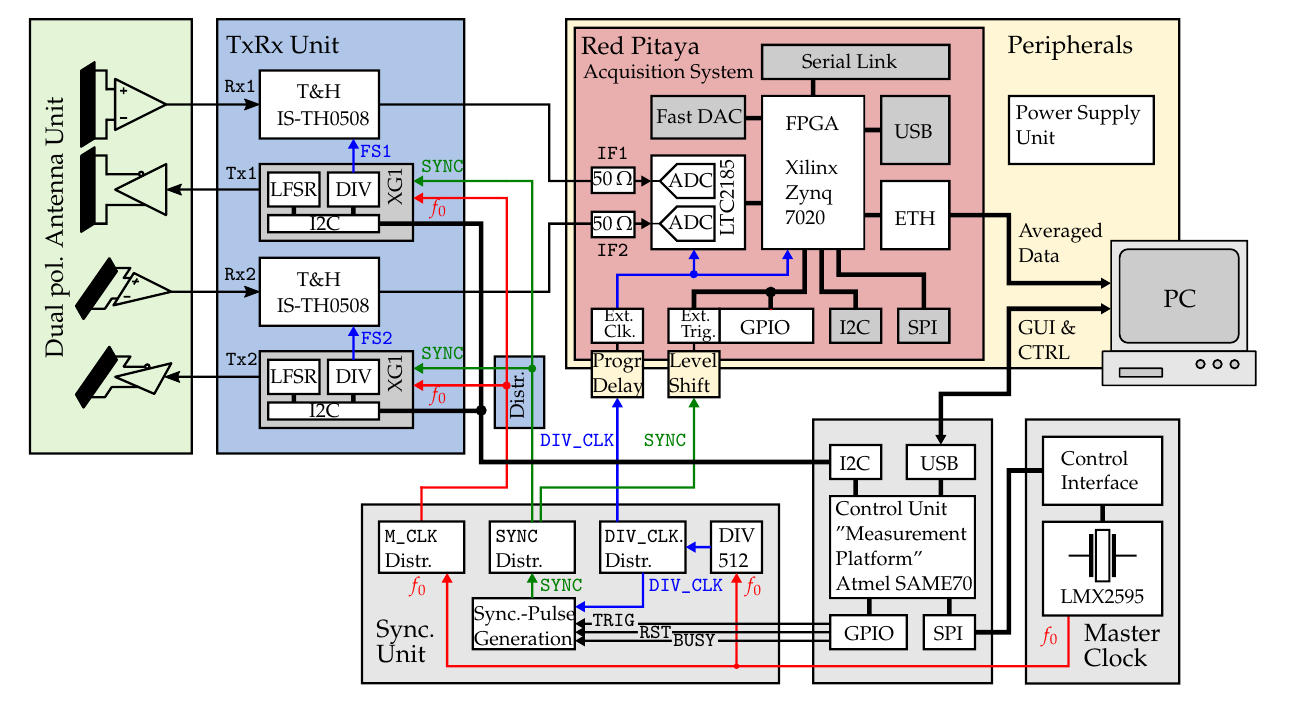
Figure 6. System architecture of the basic standalone imaging node. The colored arrows represent the different signal classes. Red symbolizes the fast M_CLK at frequency f 0 , blue symbolizes the divided clock signals at frequency f S , and green marks the signal lines for the synchronization of the